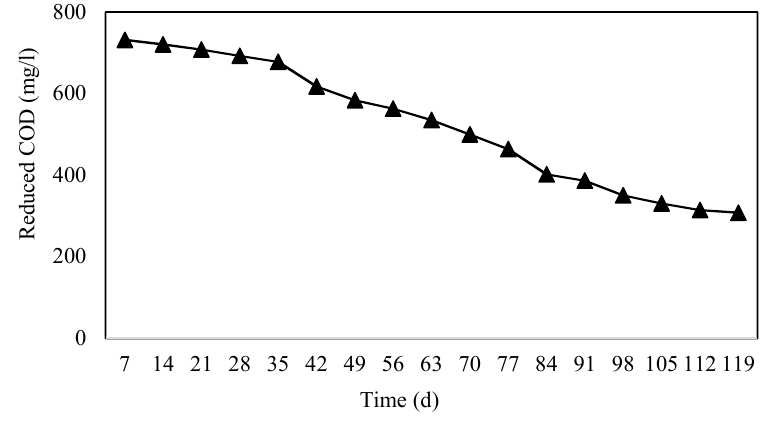
Fig. 4. Effect of rhamnolipid on COD removal in induced aeration. (rhamnolipid concentration, 60 mg/l)